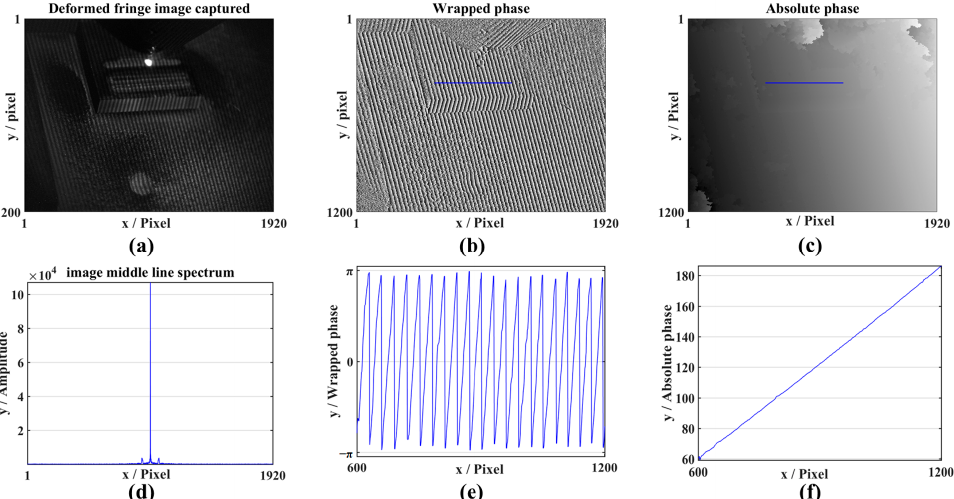
Figure 7. Actual additive manufacturing test: ( a ) a frame of the deformed fringe image in the printing process; ( b ) Wrapped phase of ( a ); ( c ) Unwrapped phase of ( b ); ( d ) Section line of Fourier spectrum of ( a ); ( e ) Profile of ( b ) along the scribed line; ( f ) Profile of ( c ) along the scribed line.